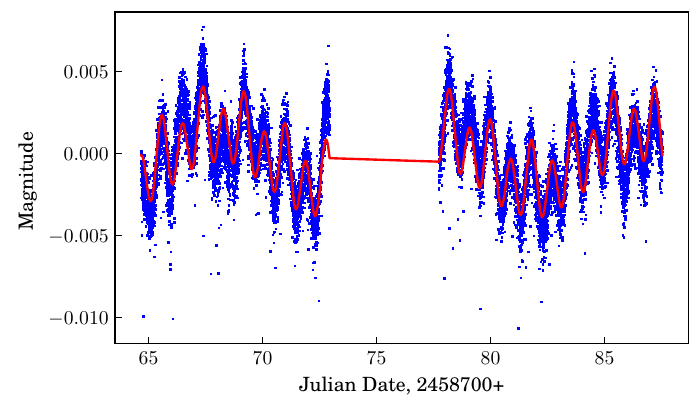
Figure 2. TESS photometry of HD6757 and its fit with a combination of two periodic functions.